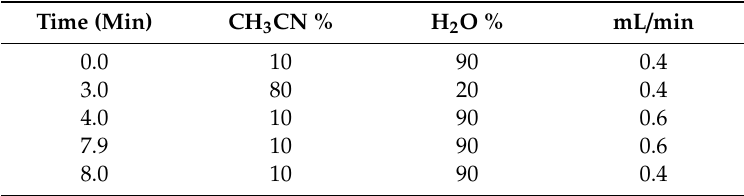
Table 5. Gradient elution